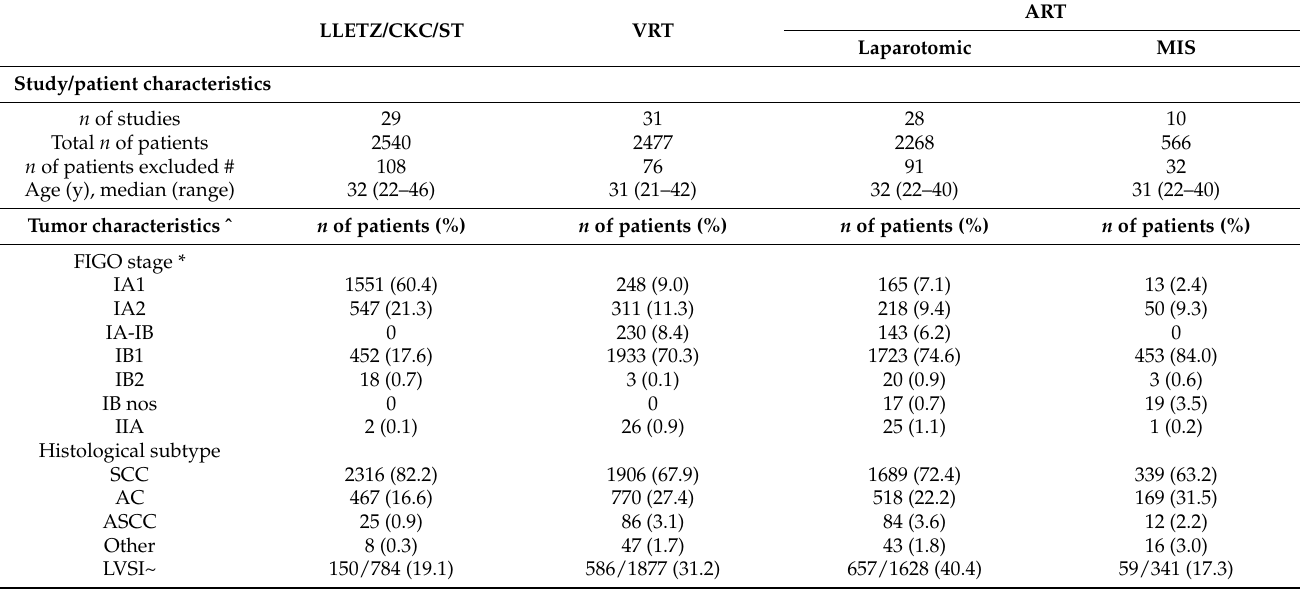
Table 1. Main characteristics of patients with cervical cancer undergoing